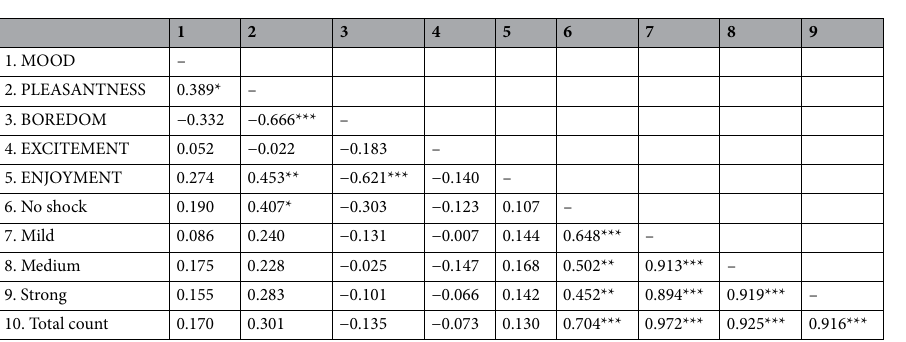
Table 3. Spearman’s rank-based correlations between mood change, ratings of the thinking period, and counts of keypresses producing (no) shocks during the thinking period. * p < .05, ** p < .01, *** p <